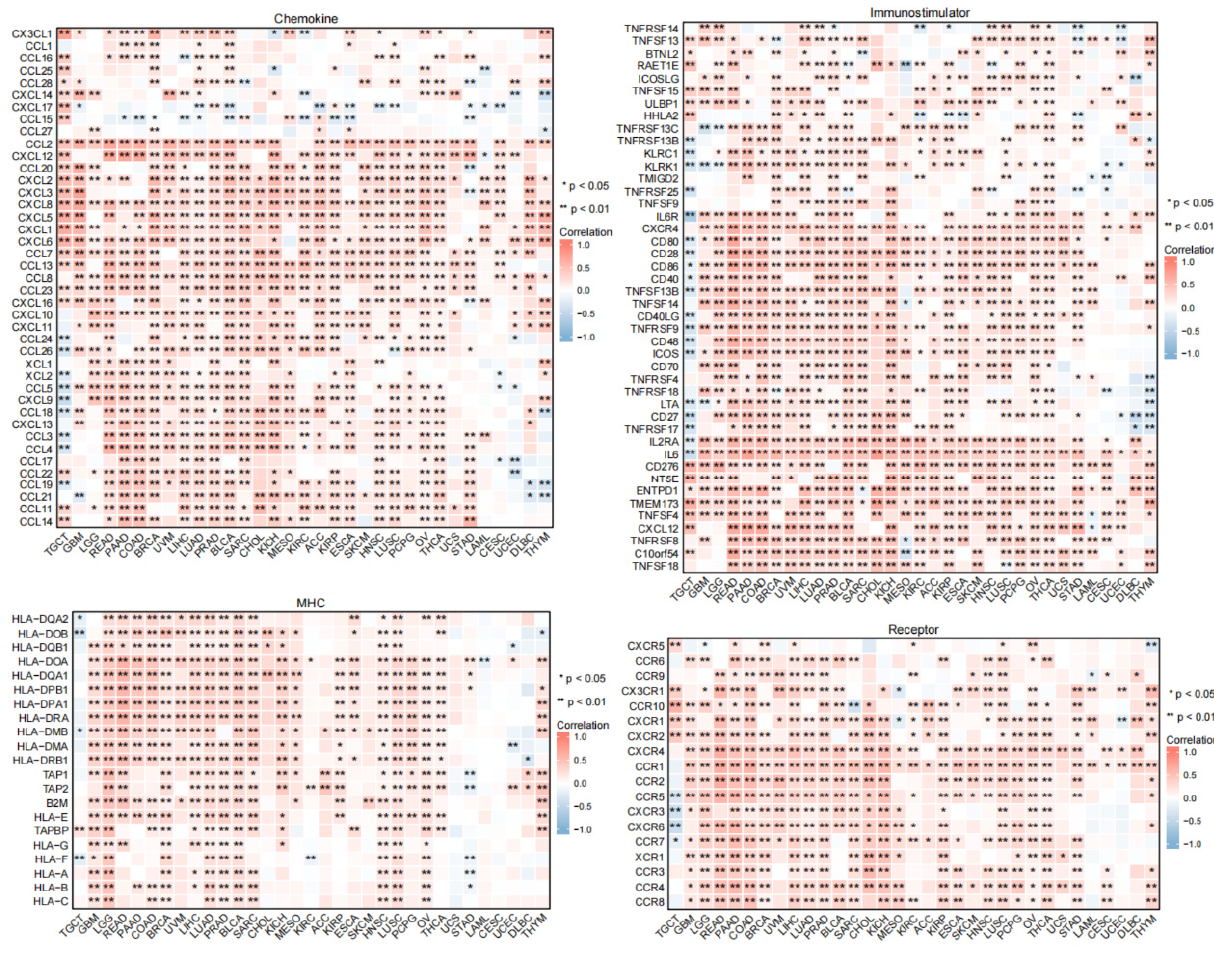
Figure 8. Correlation between PTX3 and immune-related genes. (Genes encoding MHC, immune activation, chemokine, and chemokine receptor proteins were analyze. * p < 0.05; ** p < 0.01).